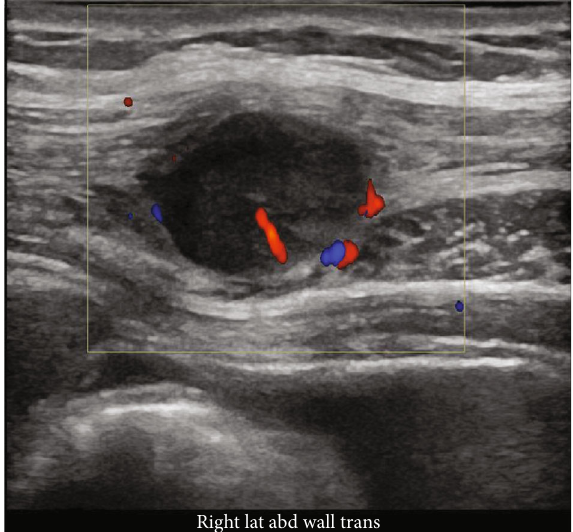
Figure 7: Doppler ultrasound con fi rming the subcutaneous nodule with internal vascularity and distortion of associated subcutaneous tissue planes, performed concurrent with image-guided